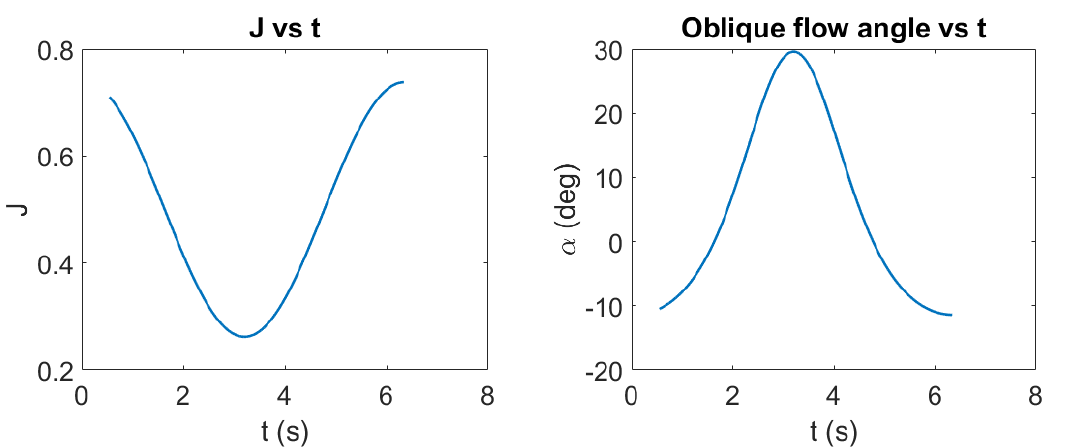
Figure 22. J (left) and α (right) as a function of time for Test 3.